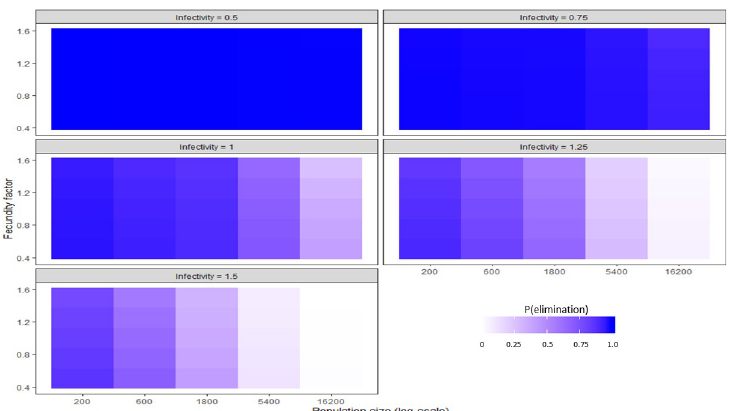
Fig 14. A heatmap showing the effect of population size, infectivity and fecundity on P(elim.) at 30% herd immunity.